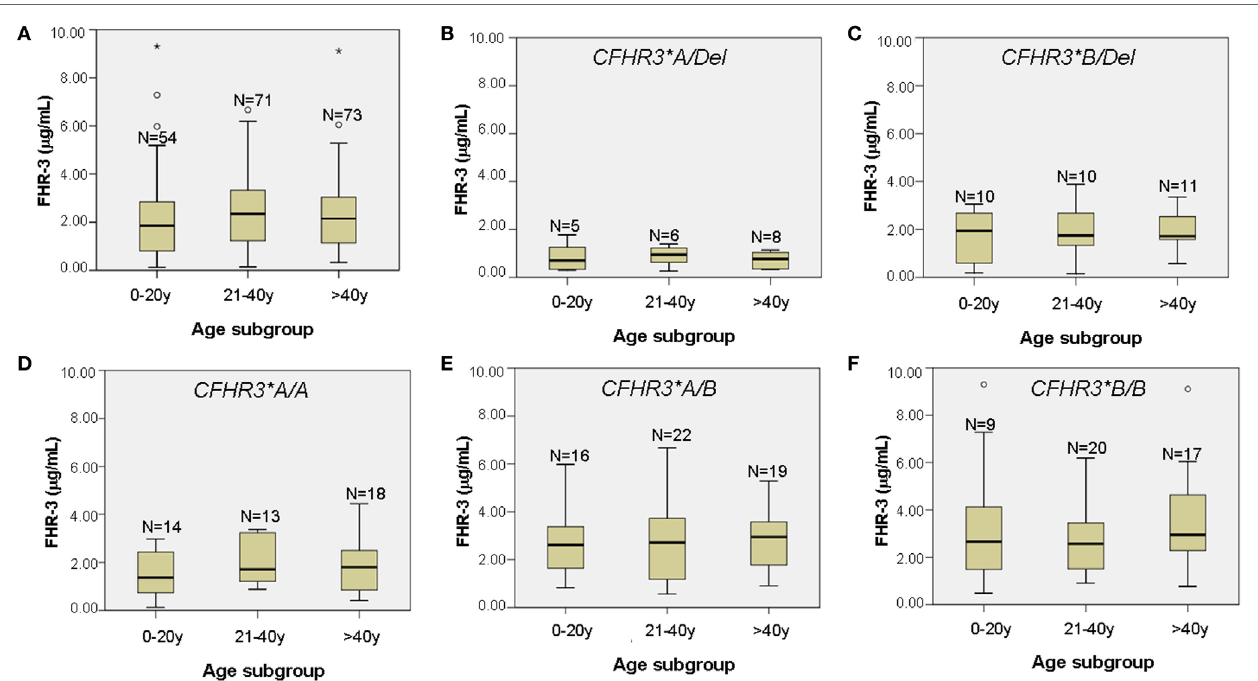
FigUre 4 | FHR-3 levels in patients with atypical hemolytic uremic syndrome (aHUS) do not change with age. (a) Boxplot of FHR-3 levels in 198 aHUS patients with the CFHR3 genotypes A/Del , B/Del , A/A , A/B, or B/B , subgrouped according to their age at blood sampling (in years). (b–F) Boxplots of FHR-3 levels in each of the five CFHR3 genotype groups. The number of patients within each age subgroup is also shown. Outliers are denoted by symbols